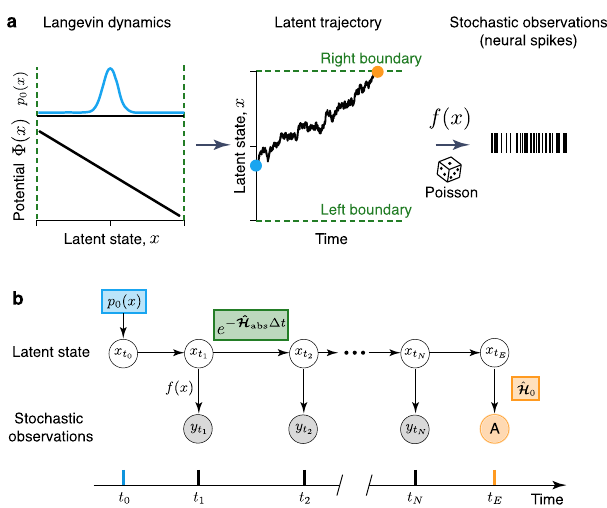
Fig. 1 Inference framework for latent non-stationary Langevin